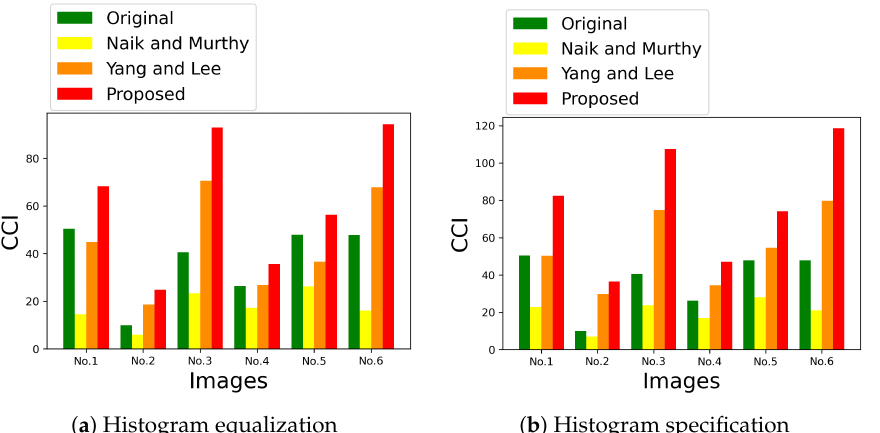
Figure 17. Color colorfulness index (CCI) [4]: the intensities are transformed by histogram equaliza- tion ( a ) and histogram specification ( b ).